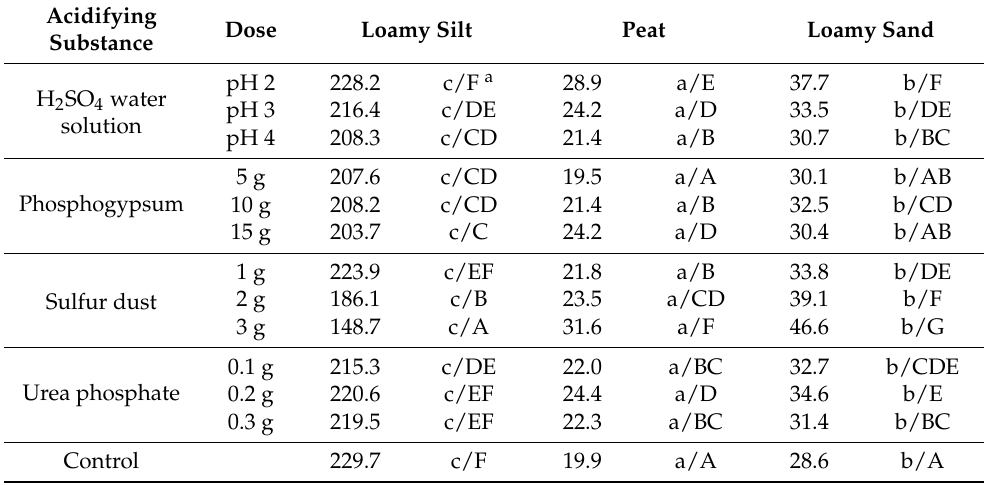
Table 5. Effects of acidifying substances after 12 months on the content of available potassium in loamy silt, peat and loamy sand